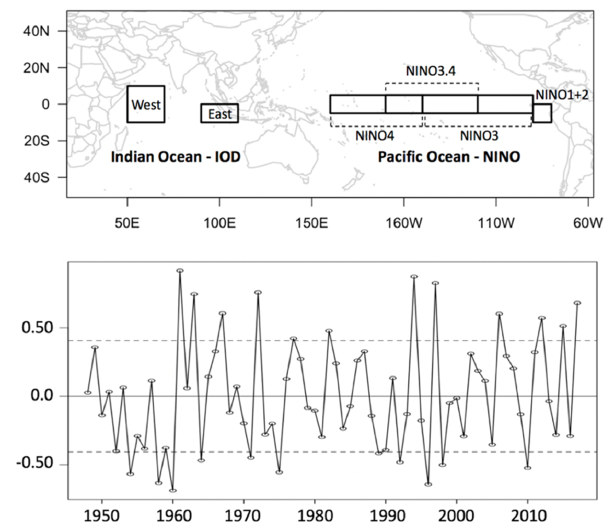
Figure 2. Dipole mode in the tropical Indian Ocean (TIO) and Niño region in the Pacific Ocean. The Indian Ocean Dipole (IOD) index is defined based on the sea surface temperature anomaly di ff erence between the western (10 ◦ S–10 ◦ N, 50 ◦ –70 ◦ E) and southeastern (10 ◦ S to the equator, 90 ◦ –110 ◦ E) regions of the TIO shown in the upper panel. In the lower panel, the IOD time series during 1948–2017 is shown by the solid line, and the ± 1 SD of the IOD is marked by dotted